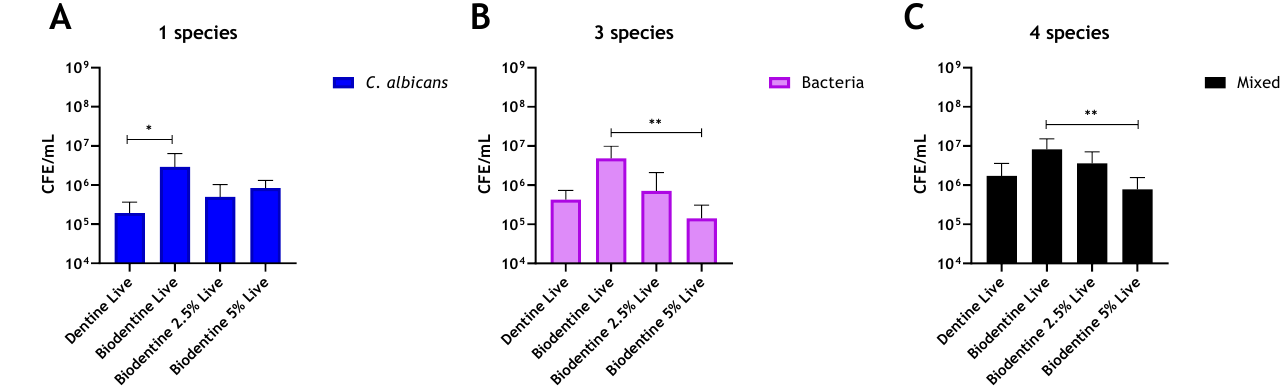
Figure 4. Compositional analysis of regrown biofilms on Biodentine material discs. Chitosan amounts of 2.5 wt% and 5 wt% were incorporated into Biodentine material, and live/dead qPCR was performed on ( A ) Live CFE/mL of C. albicans biofilms, ( B ) Live CFE/mL of bacterial biofilms and ( C ) Live CFE/mL of 4-mixed biofilms (bacteria and Candida). Bovine dentine and unaltered Biodentine discs were used as controls. Data were analysed by Kruskal–Wallis with Dunn’s tests. * Indicates statistically significant differences (* p < 0.05, ** p < 0.01).